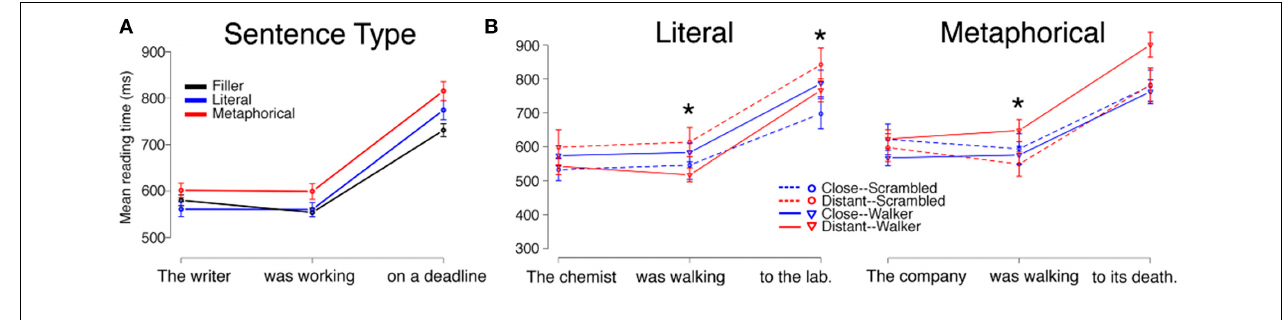
FIGURE 2 | Reading times for sentence regions from Experiment 1 are displayed by (A) Sentence Type and (B) by Verb Match and Prime Type for Literal and Metaphorical sentences. Error bars represent standard errors of the mean. Interactions between Verb Match and Prime Type at the